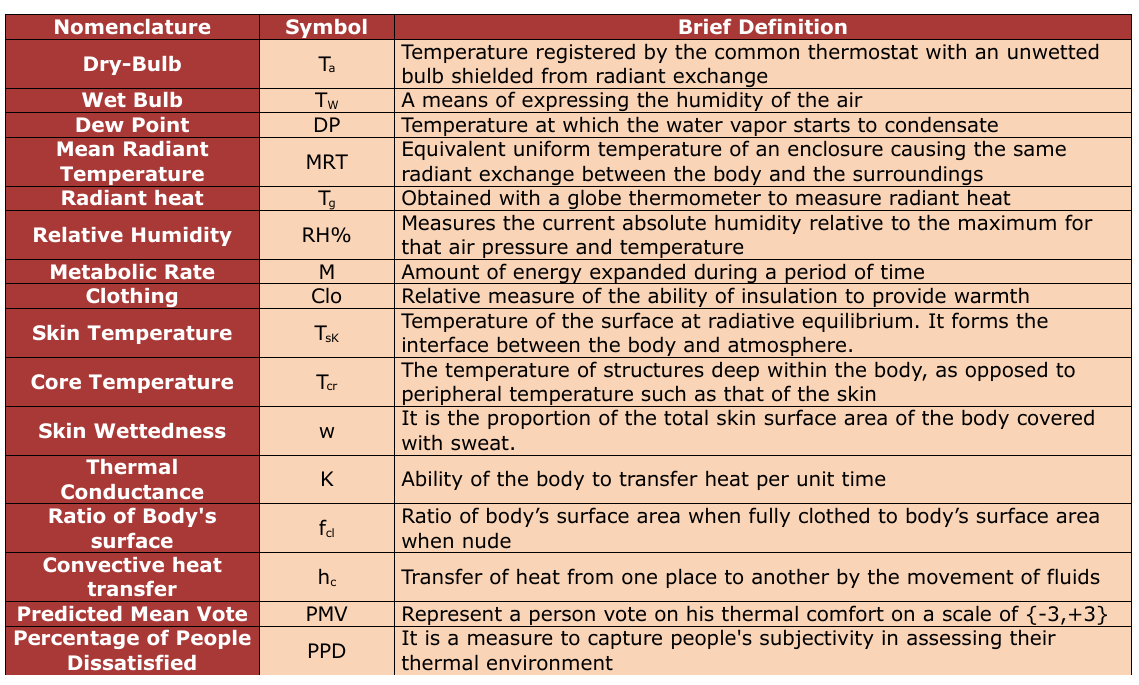
Table 1. Nomenclature Main heat computation variables